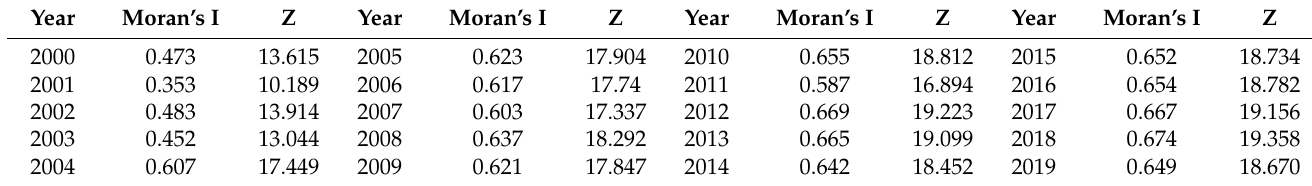
Table 2. Moran’s I of the CDUFS.